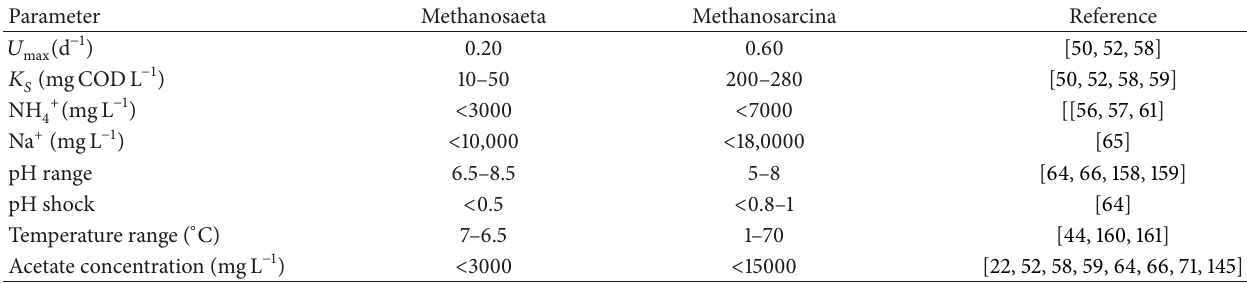
Table 2: Kinetics characteristics of various methanogens.